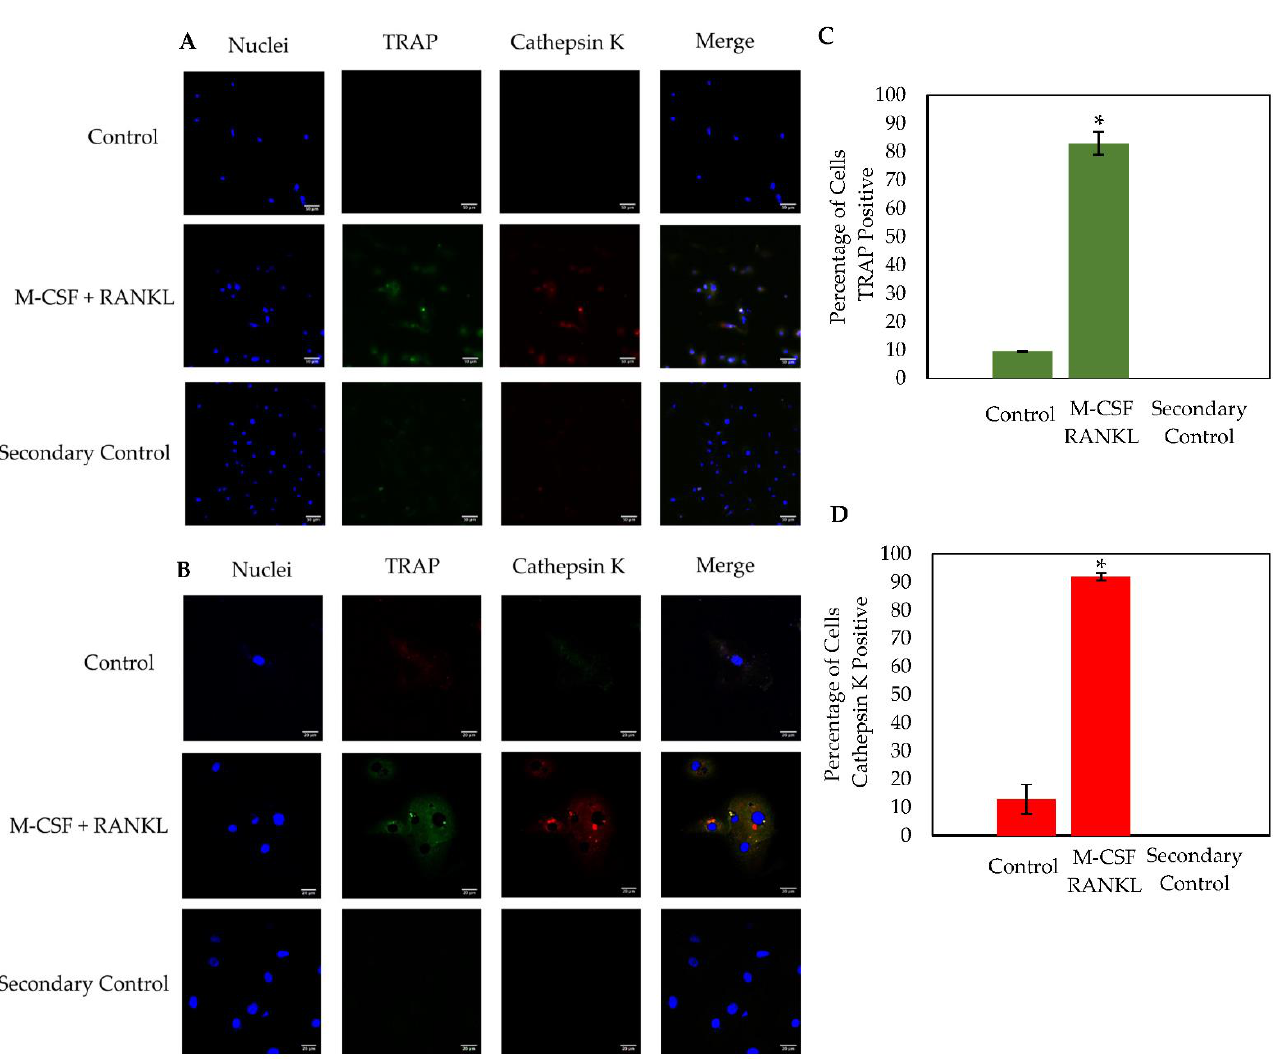
Figure 7. Immunostaining of cells isolated from male ( N = 2) and female ( N = 1) OA patients. Confocal microscopy was utilized to image cells at 20 × ( A ) and 63 × ( B ) magnification. The population of cells stimulated with M-CSF + RANKL was ~60%, whereas the control group had ~15% osteoclasts. As displayed in the figure, M-CSF + RANKL stimulated highly expressed TRAP and Cathepsin K cells, while the control cells produced very little of these osteoclast markers ( C, D ). Cells from 10 representative images obtained at random from all three patients were counted. The RANKL stimulated cells expressed significantly higher TRAP and Cathepsin K than the control groups ( C, D ). Experiments were completed in triplicate and processed using ImageJ. All fluorescence was normalized to the secondary control. “*” denotes statistical significance, where p is set to 0.05.